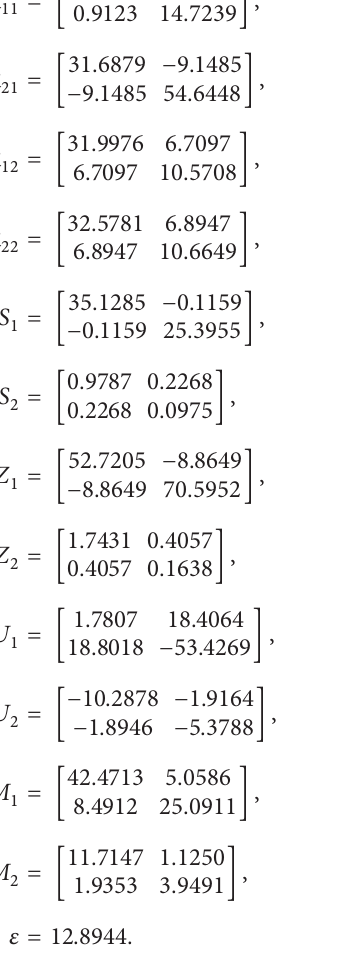
Table 1: The upper bound of ℎ 21 for different ℎ 11 .